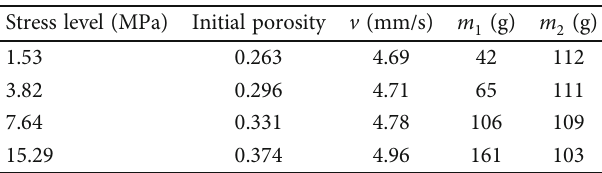
Table 2: Water and sediment seepage test data of broken rock samples under di ff erent loads.